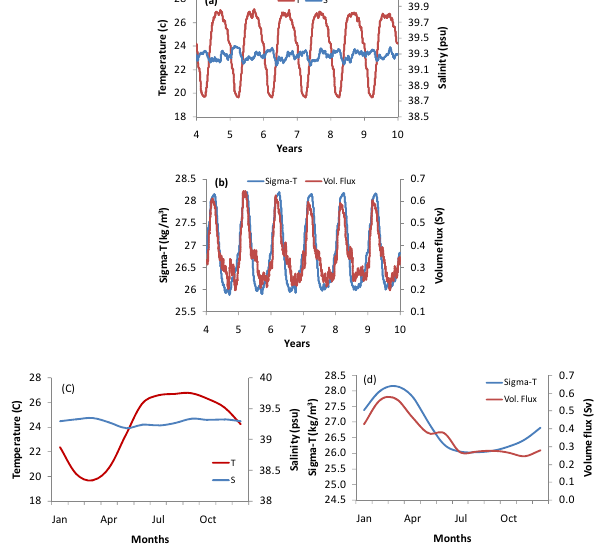
Fig. 8. Time series of (a) the mean PG outflow temperature, salinity, (b) volume flux and σ - T . (c) The monthly mean for the last year of integrations of the outflow temperature, salinity, (d) volume flux and σ - T , at transect IJ (see Fig. 4).